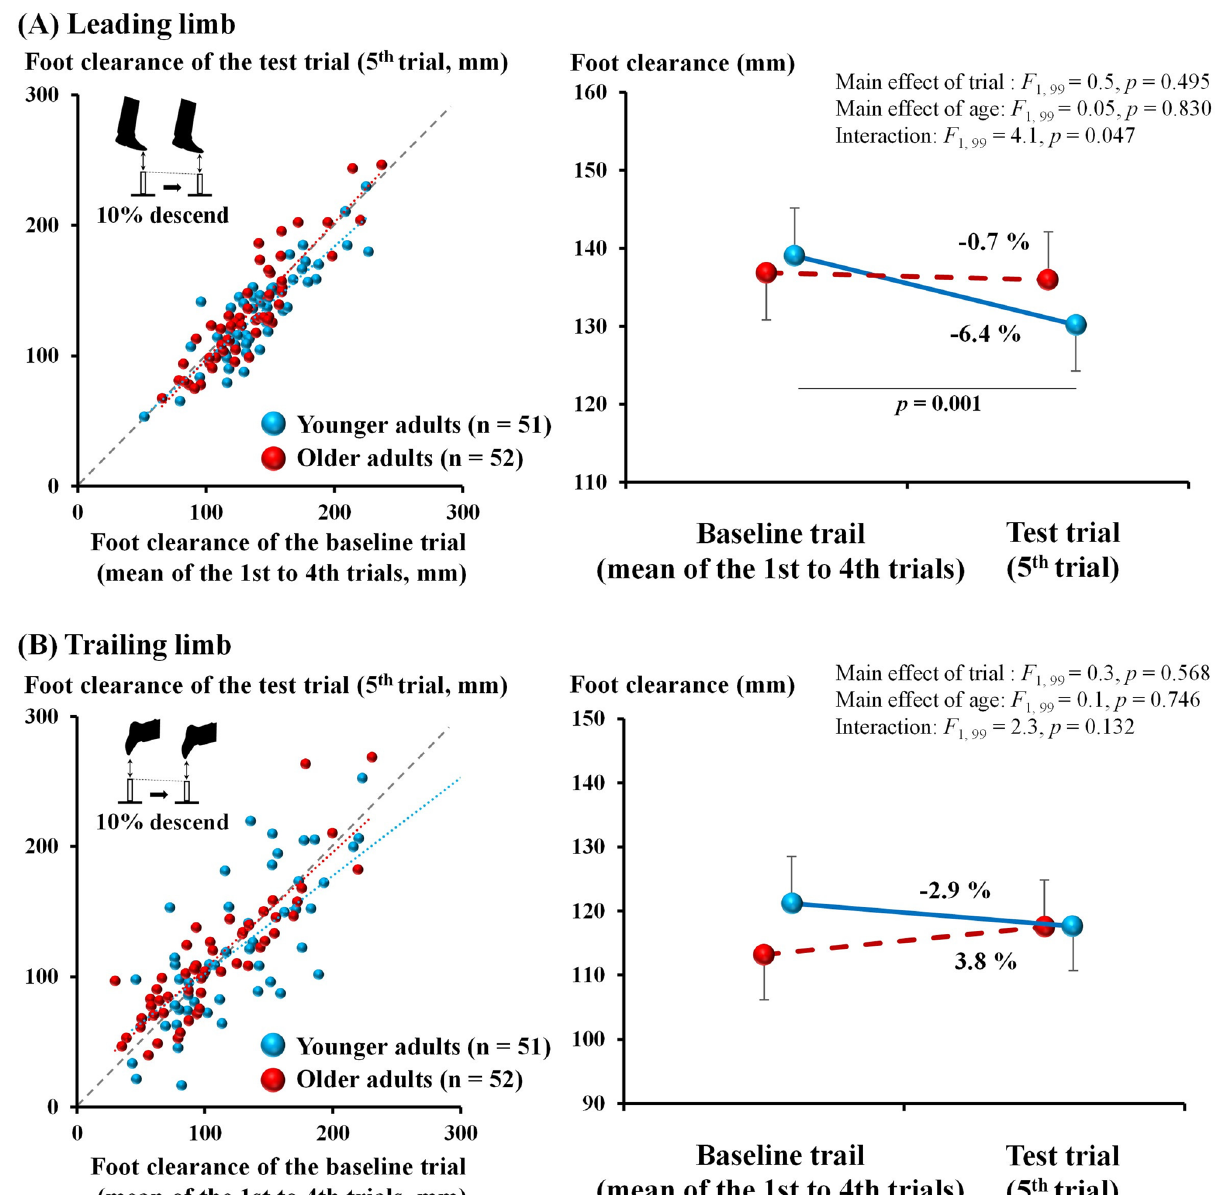
Figure 2. Comparison of the foot clearance in the descending condition for the younger and older adults. Left side: scatter diagrams of the foot clearance in the mean foot clearance of the first to fourth trials (i.e., baseline trial) and fifth trial (i.e., test trial) for the young and older adults. Data points above or below the diagonal line show participants who increased or decreased their foot clearance in the fifth trial. The light blue and red dashed lines indicate the regression lines of the young and older adults, respectively. Right side: line graphs of the foot clearance in the fifth trial and the mean foot clearance of the first to fourth trials for the young and older adults (error bars indicate standard errors). For both scatter and line diagrams, the upper scatter diagram ( A ) is for the leading limb and the lower scatter diagram ( B ) is for the trailing limb. Bars and error bars indicate adjusted mean values and standard